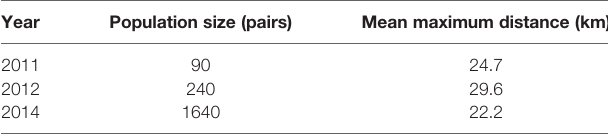
Population size for 2011 and 2012 are from Pozzi et al. (2015), and the size for 2014 was calculated using the growth rate in that paper. Mean maximum distance is the mean distance of the longest trip for each penguin in each year.